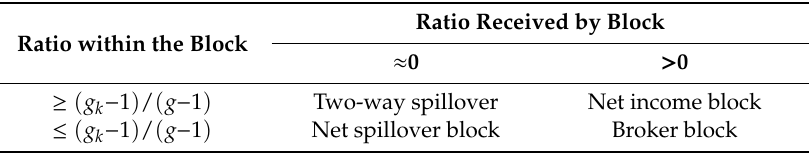
Table 1. Block model division in the ANTCE